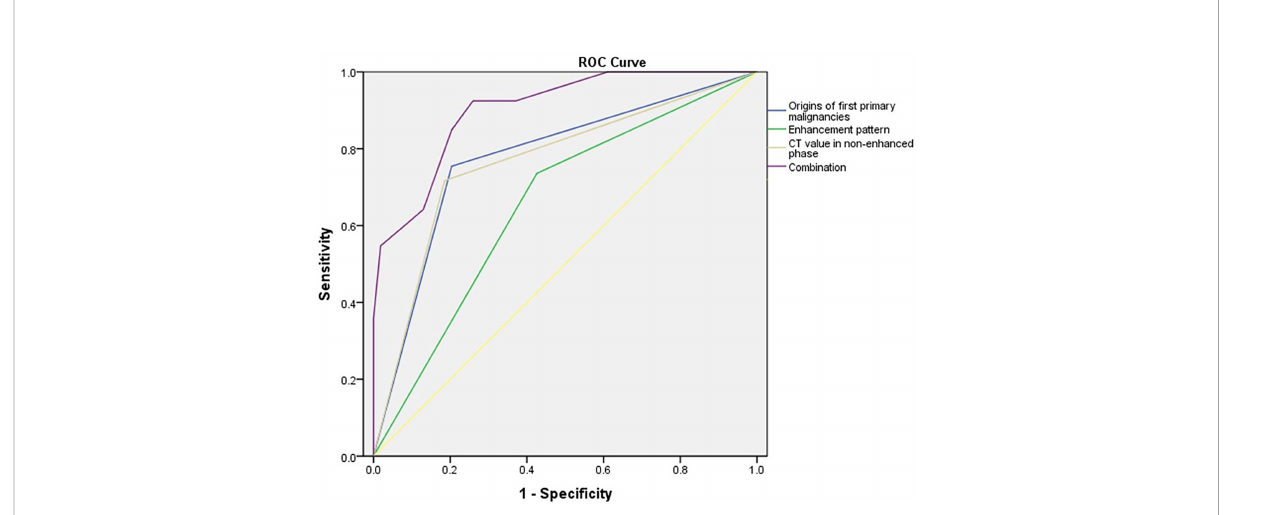
FIGURE 1 Receiver operating characteristic (ROC) curves for the differentiation of adrenal metastases and benign adrenal masses using a logistic regression model that included the origins of fi rst primary malignancies, enhancement pattern, attenuation values in non-enhanced phase (HU) of adrenal mass and the combination. The area under the ROC curve (AUC) for each model is 0.776, 0.655, 0.766 and 0.902,